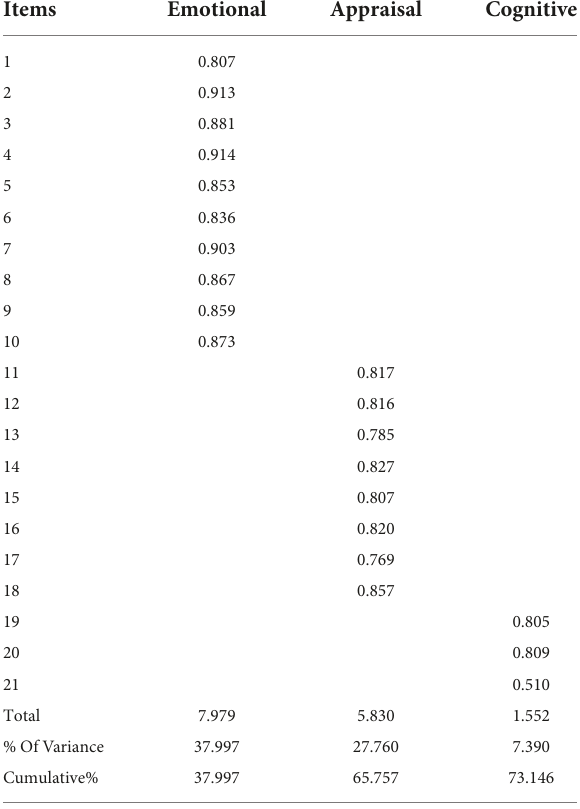
TABLE 1 Saturations of the items of the climate change perception (CCP) questionnaire by factors after the rotated component matrix.